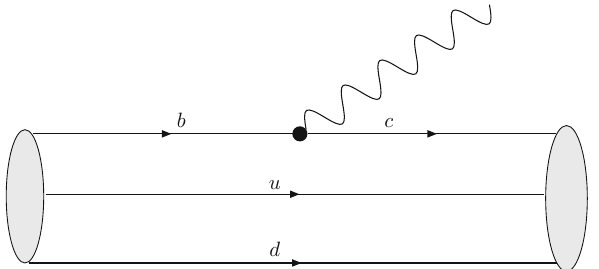
Fig. 1 TheFeynmandiagramfor (cid:2) b → (cid:2) c and (cid:3) b → (cid:3) c